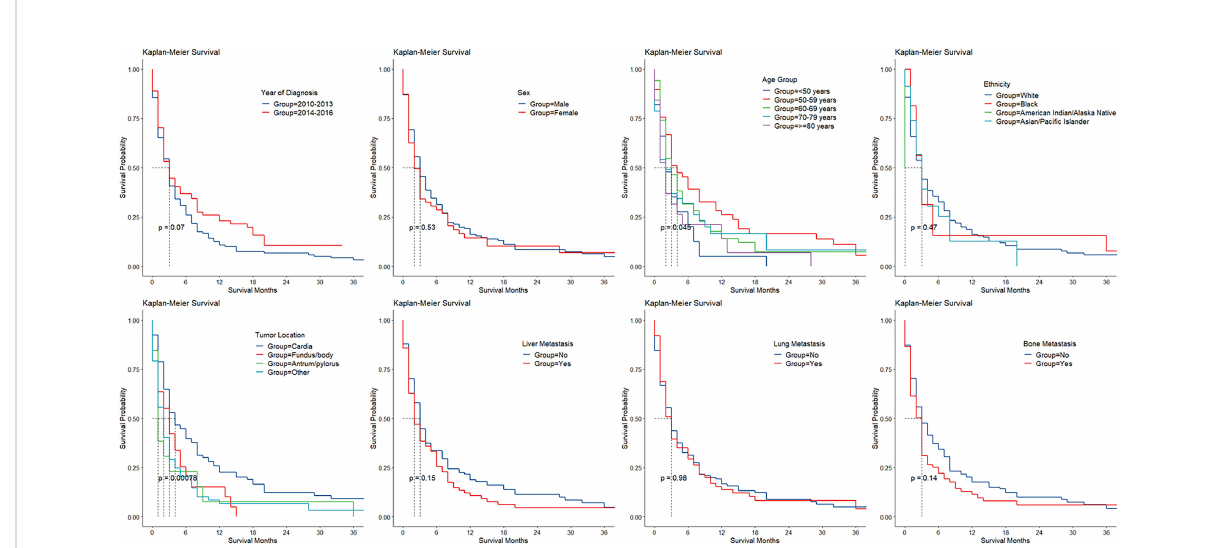
FIGURE 2 Kaplan – Meier survival by patient and cancer factors in gastric adenocarcinoma with brain